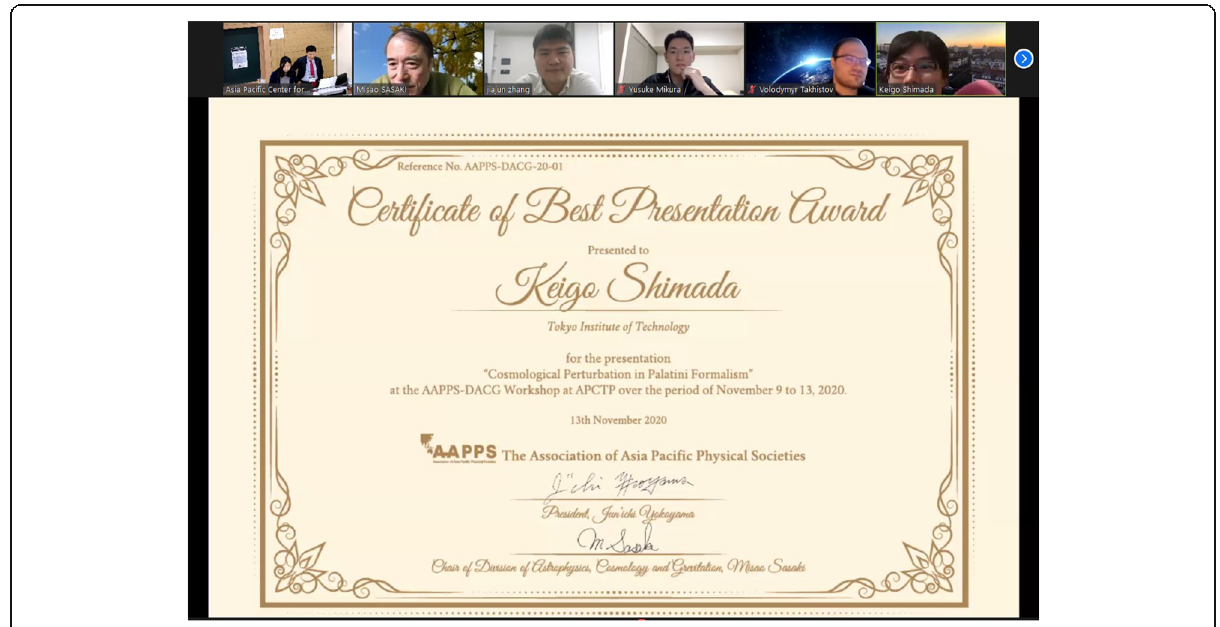
Fig. 5 The Certificate of the Best Presentation Award for Keigo Shimada, a graduate